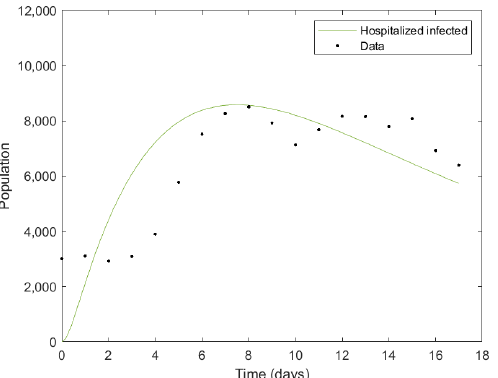
Figure 3. The simulation of the hospitalized infected population compared to the actual data from 1 January 2022 to 17 January